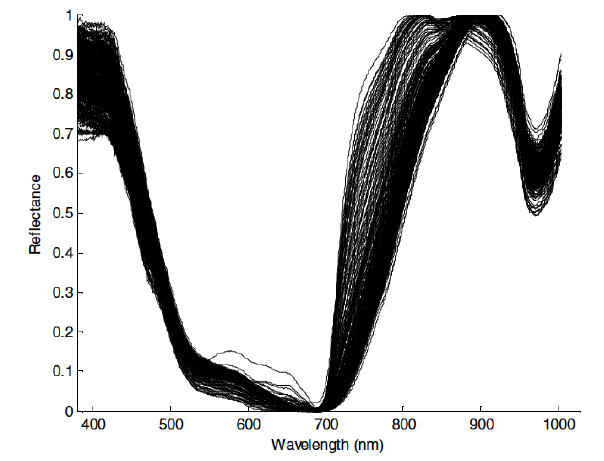
Figure 3. Reflectance measurements for the TF 2012 variety samples.